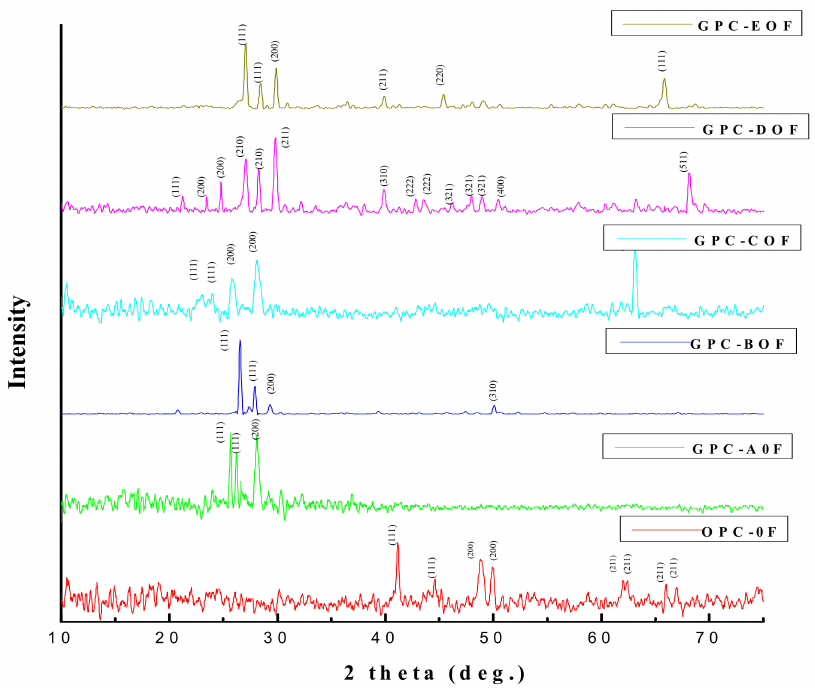
Figure 13. The XRD pattern of OPC and GPC specimens after 28